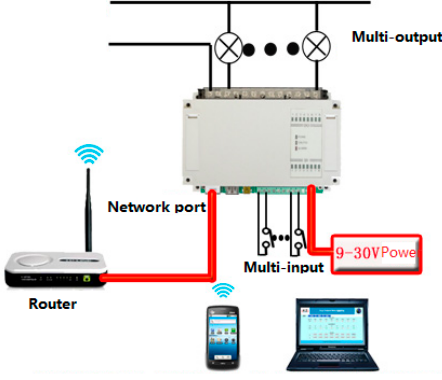
Figure 24. Remote control of the electronic device in SH.